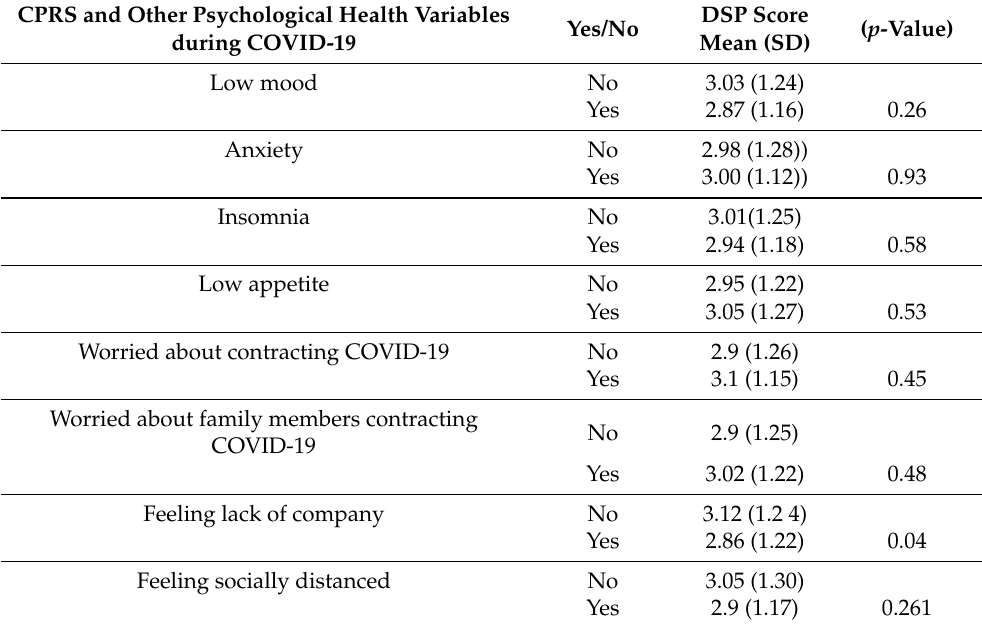
Table 4. Digital social participation score among the CPRS and other psychological health variables in a study sample of n = 394 and p -value from Mann-Whitney